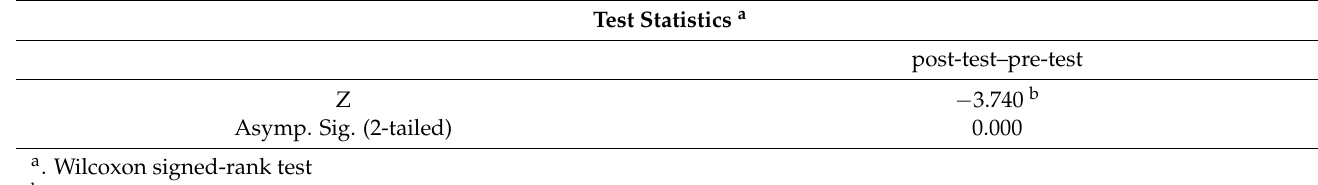
Table 6. Wilcoxon signed-rank test